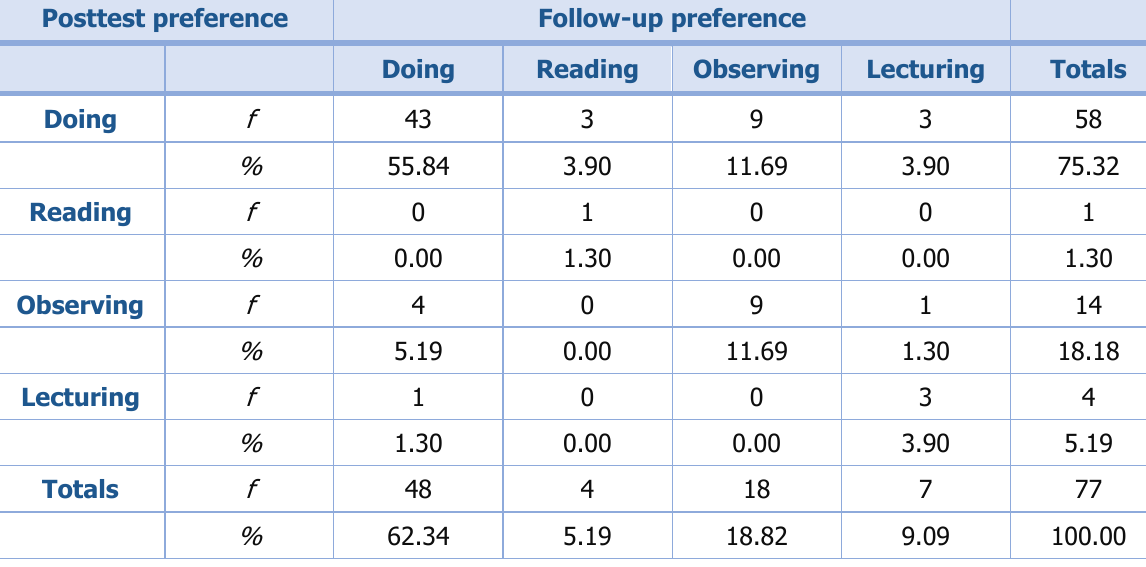
Table 3. Student Perception of Learning Mode Preference Change Posttest